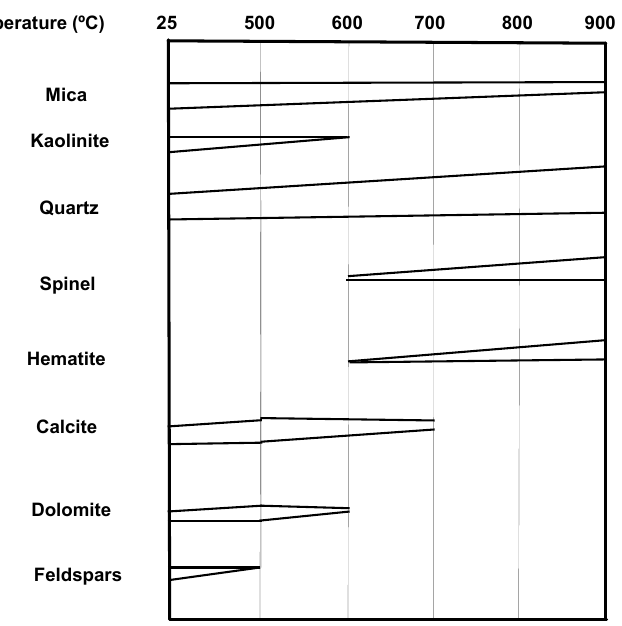
Figure 1. Mineralogical composition by X-ray diffraction (XRD) for the coal mining waste and the coal mining activated waste.